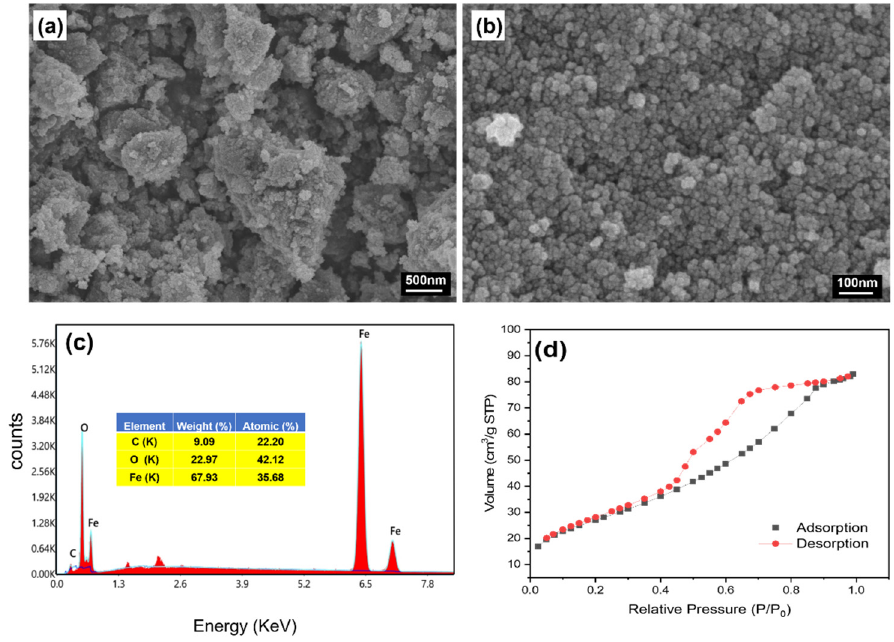
Figure 2. SEM images ( a , b ), EDS spectra ( c ), and N 2 adsorption–desorption isotherm ( d ) of IONPs@MAH- β -CD. IONPs@MAH- β